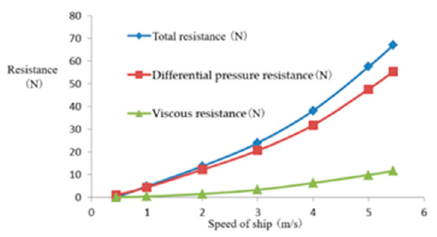
Figure 5. Relationship between differential pressure or viscous resistance and ship speed.